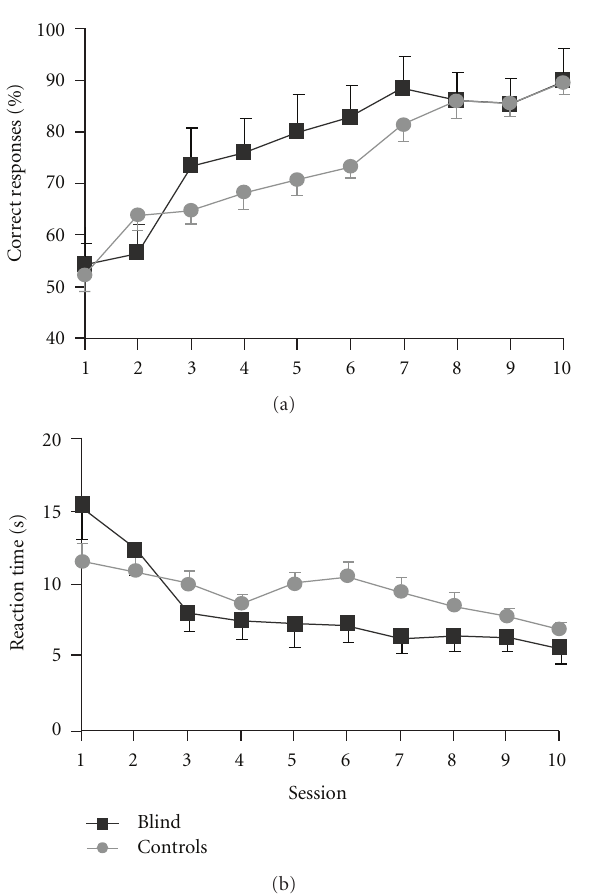
Figure 2: Learning curves for shape recognition in congenitally blind and blindfolded control subjects. (a) Mean percentage chan- ges ± SEM of correct responses and (b) mean reaction times ± SEM. No significant di ff erences in performance were observed between the groups.